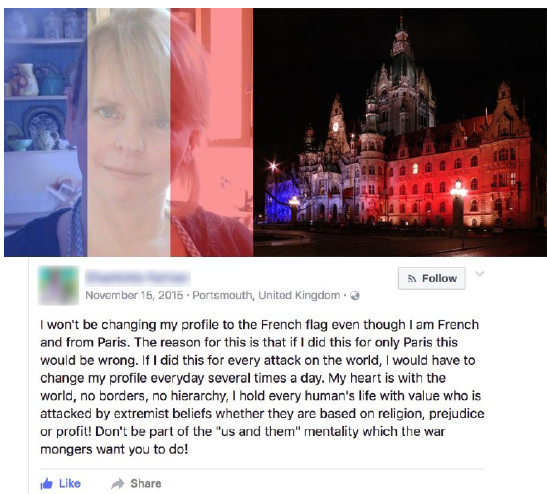
Figure 3. Conflicting approaches to the blue, white and red campaign in support of victims of the terrorist attack in Paris, 13 November 2015.